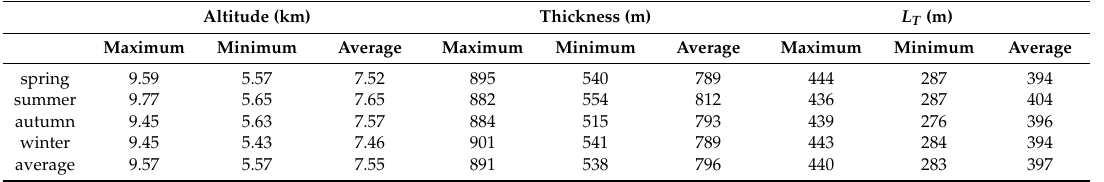
Figure 3. The distribution of SMLT of 2007 with a longitude after meridional averaging. ( a ), ( b ), ( c ) and ( d ) represent spring, summer, autumn and winter. The vertical thickness of the line represent thickness of SMLT, and the color of the line represent L T of SMLT. Table 3. Statistical characteristics of SMLT after zonal averaging in Table 2. Statistical characteristics of SMLT of 2007 after meridional averaging.